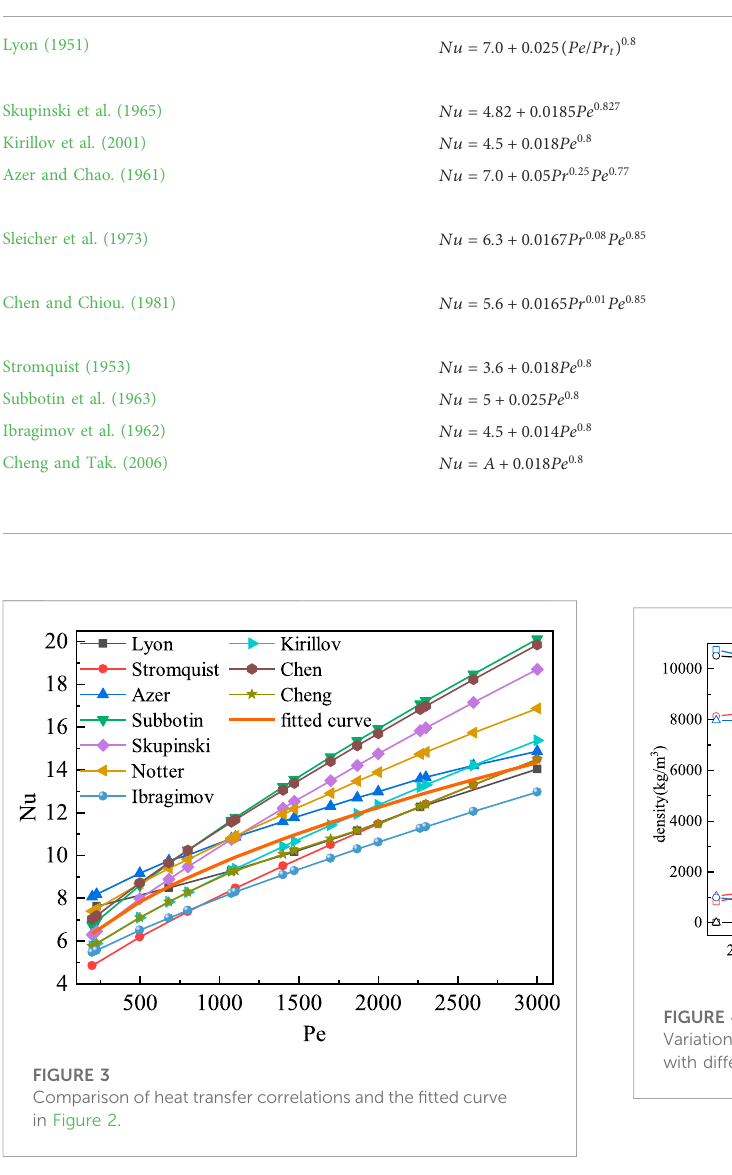
by scholars is shown in Figure 3.